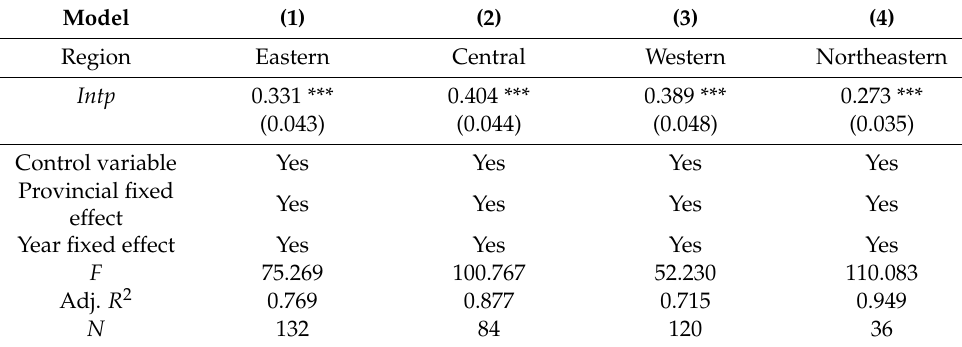
Table 9. Estimated results for the effects of IPR on CDRs by